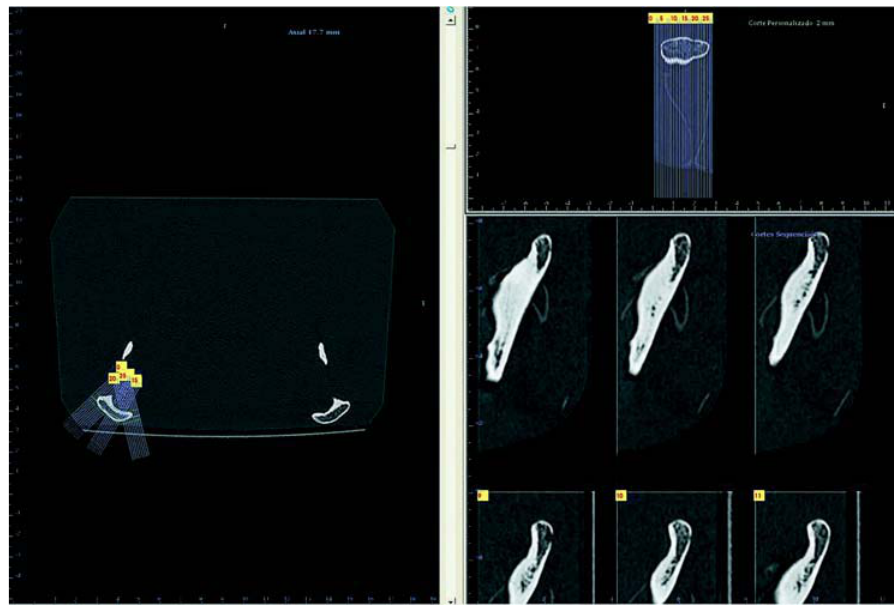
FIGURE 5- Parasagittal reconstructed images of the right side of the TABLE 1- Table of axial, coronal, sagittal images in comparison intra-observer, inter-observer with gold standard